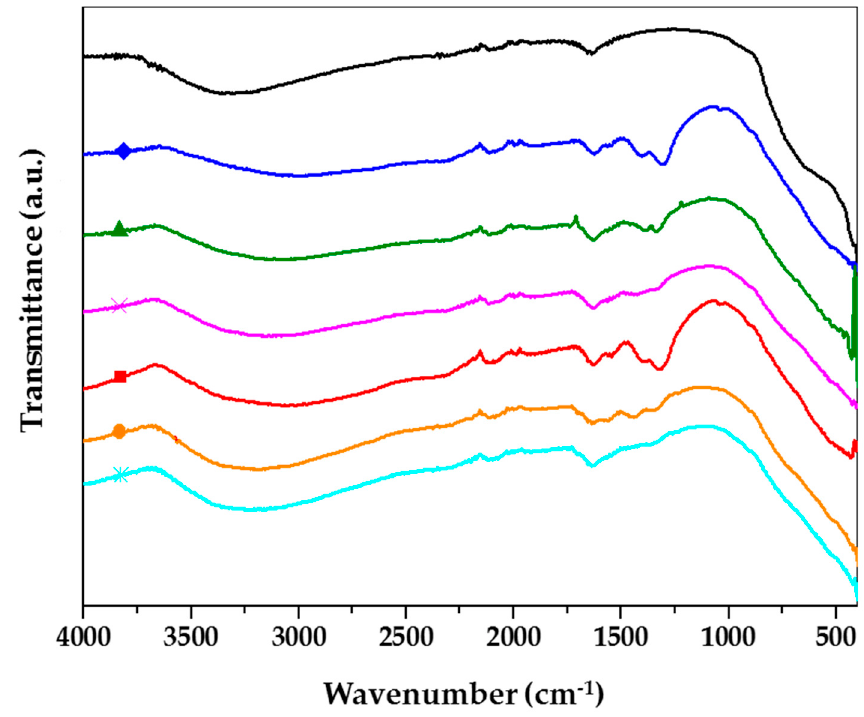
Figure 2. Fourier transformed infrared spectra (FTIR): (-) P25; ( ♦ ) pure TiO 2 , ( ■ ) TiO 2 /Zr2.8, ( ▲ ) TiO 2 /U4, ( • ) TiO 2 /U4/Zr2.8, ( × ) TiO 2 /N42, (*) TiO 2 /N42/Zr2.8.